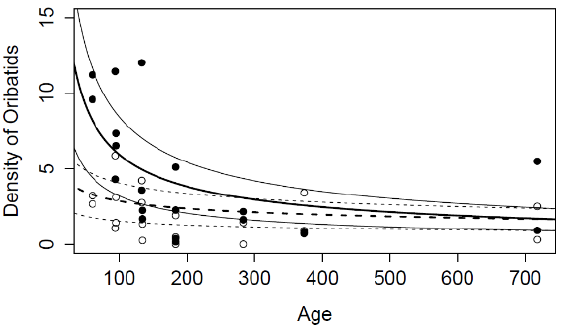
Figure 1. Total density of adult oribatids (individuals/g of dry substrate) plotted against stand age (years since fire). Black dots correspond to adjacent position relative to coarse woody material (CWM) and open circles to samples under CWM. The solid line corresponds to the line of predicted values for adjacent samples while the dashed line corresponds with the predicted values from the mixed model for samples under CWM. Thinner lines represent error intervals for each line of predicted